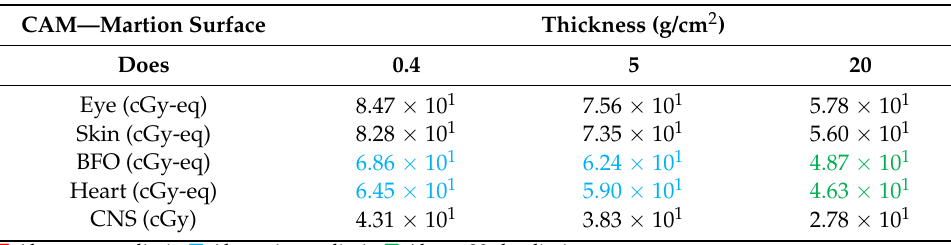
Table 5. Organ doses from 993/4 SPE for CAF on the surface of Mars behind various thicknesses of aluminum shielding.